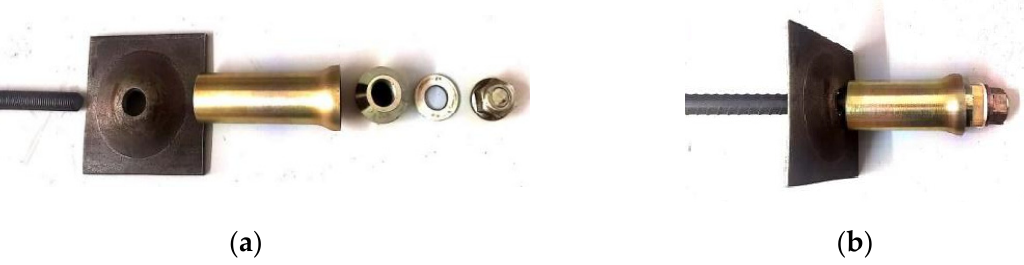
Figure 2. The actual structure of energy absorbing anchor ( a ) before assembly; ( b ) after assembly. During the installation process, the drilling rod is first used to make a hole in the coal (rock) body, and then the energy-absorbing anchor rod is screwed into the hole by relying on a certain torque. This fundamentally improves the strength and safety of the support structure; enhances the efficiency and quality of the anchor installation process; makes the monitoring of pre-stress and anchorage force more convenient, accurate, and systematic; greatly improves the efficiency of coal mine employees; reduces the waste of human and material resources; and ensures that the deep shaft anchor support solution has higher economic practicality and technical feasibility.